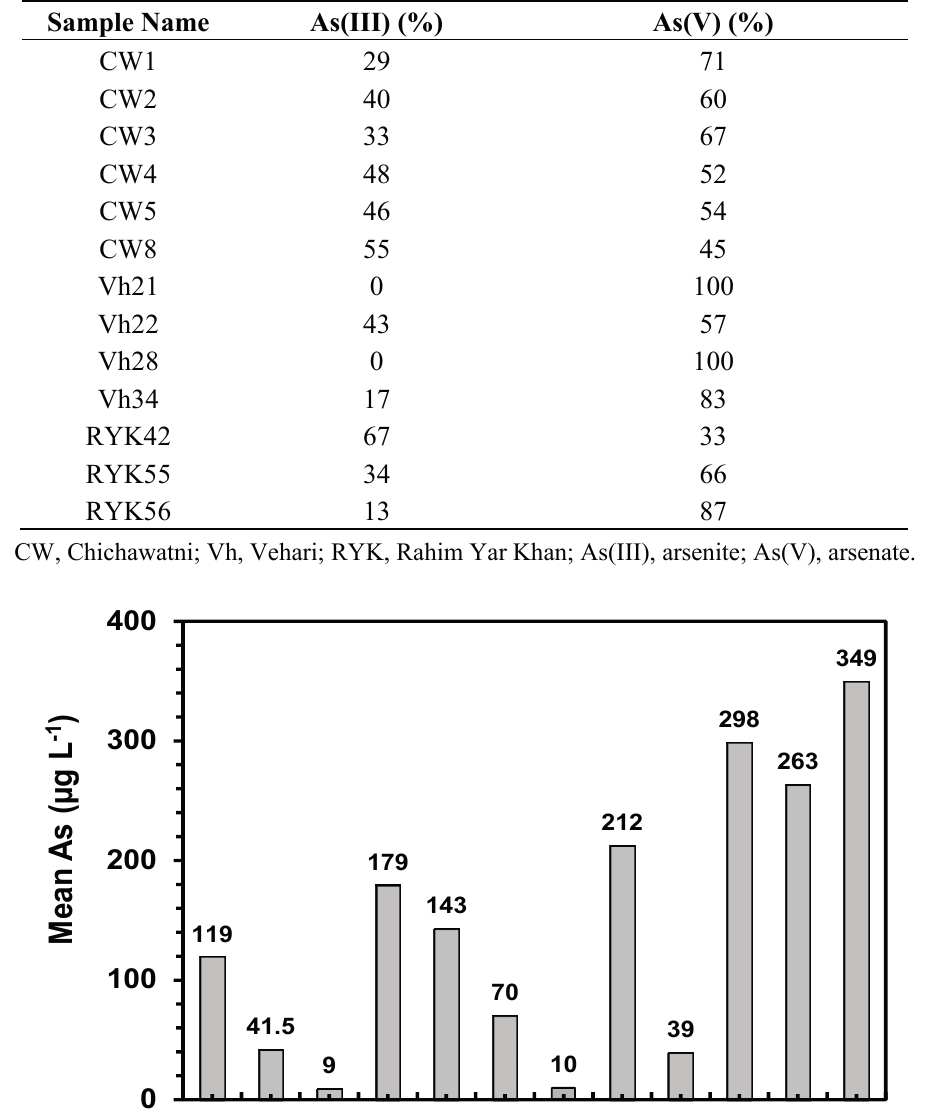
Table 2. Speciated As contents in selected groundwater samples ( n = 13) collected from three rural areas of Punjab, Pakistan.